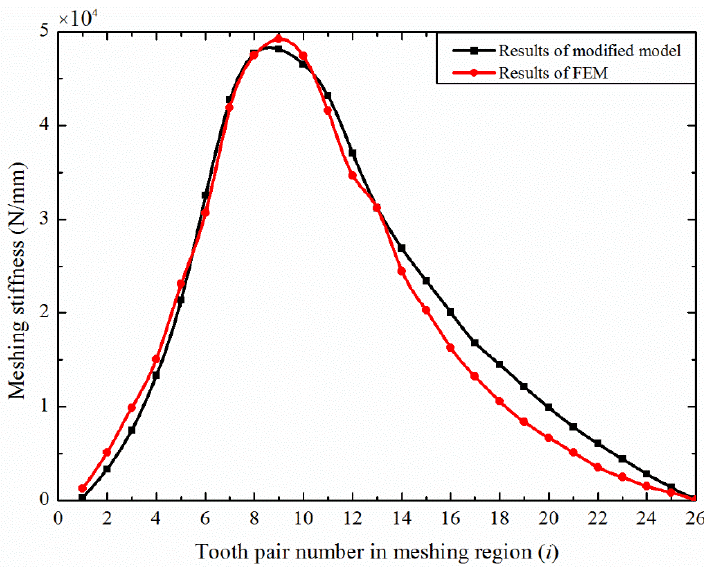
Figure 23. Coefficients of stiffness obtained by the modified analytic method and the FEM.